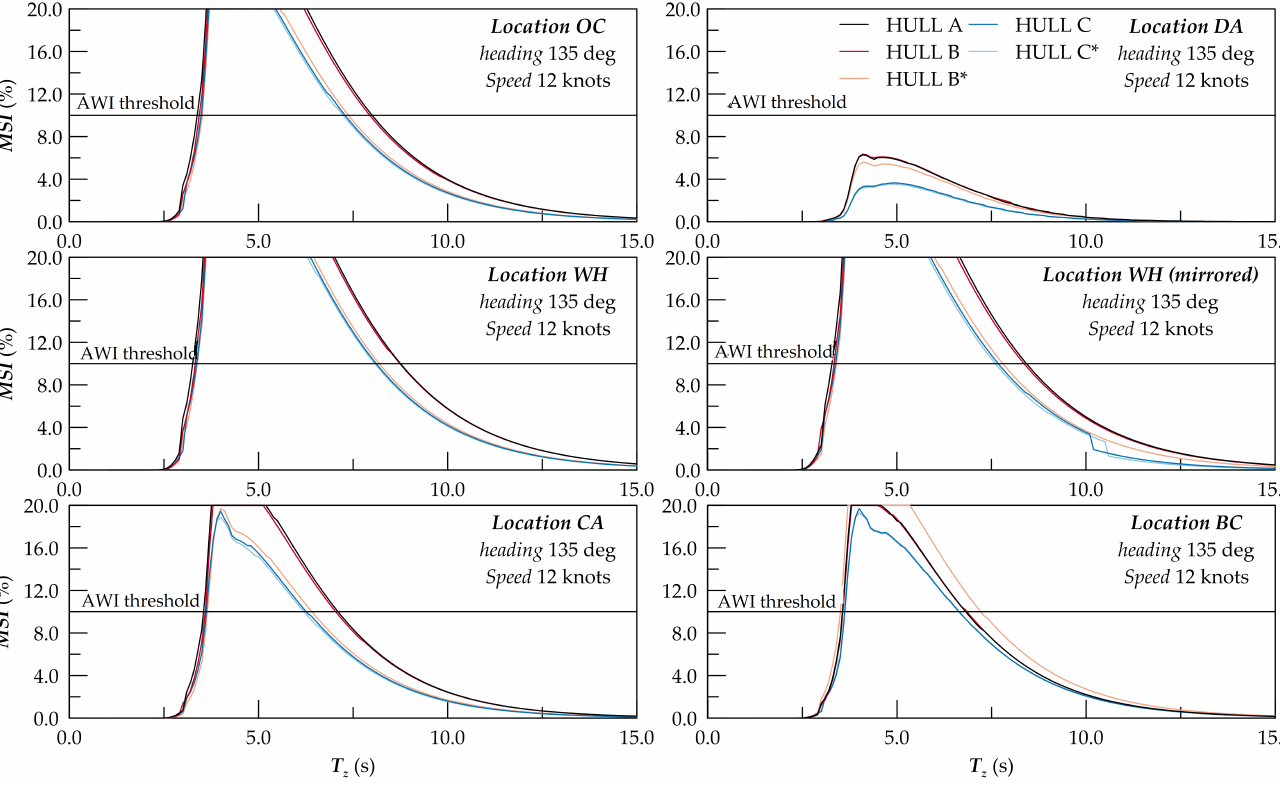
Figure 21. MSI values for H s = 1.5 metres at different T z for the AWI 22834 locations at 12 knots. Table 5. OP C and comfort ratings according to AWI 22834 criteria for the different hull